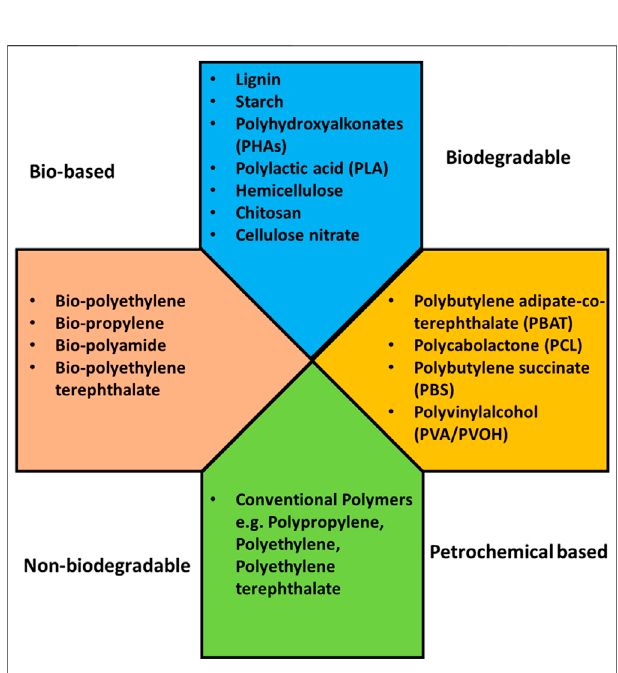
FIGURE 3 | Biodegradability and sources of polymers and biopolymers (Reconstructed from. Helanto et al. (2019)).